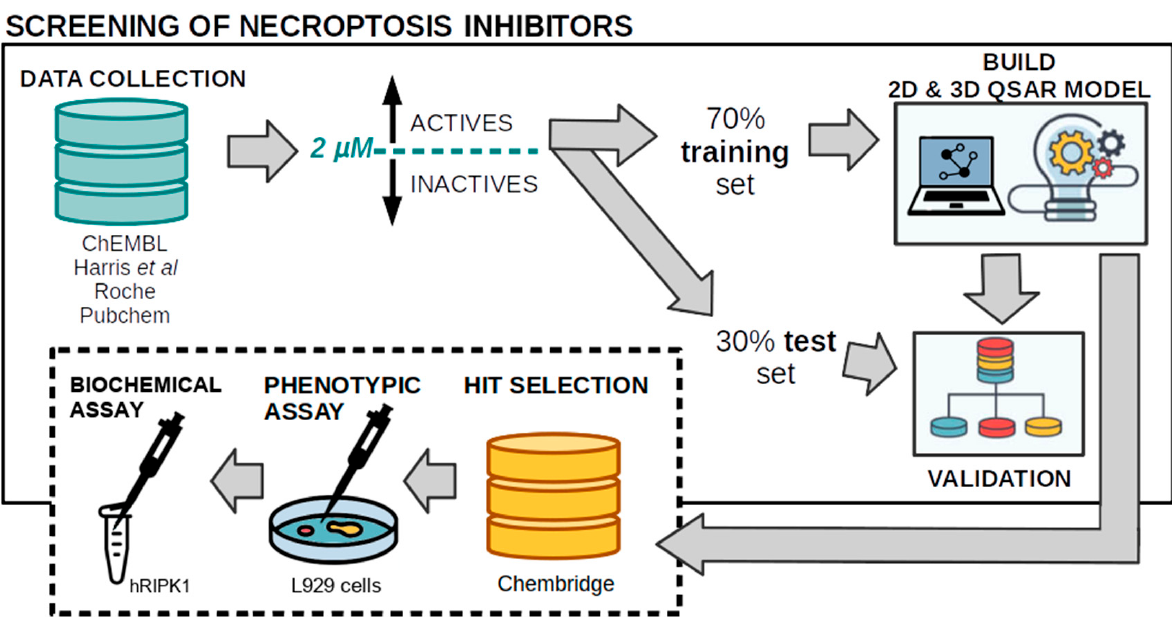
Figure 4. Workflow of the proposed methodology (computational and experimental) to predict RIPK1 inhibitors.